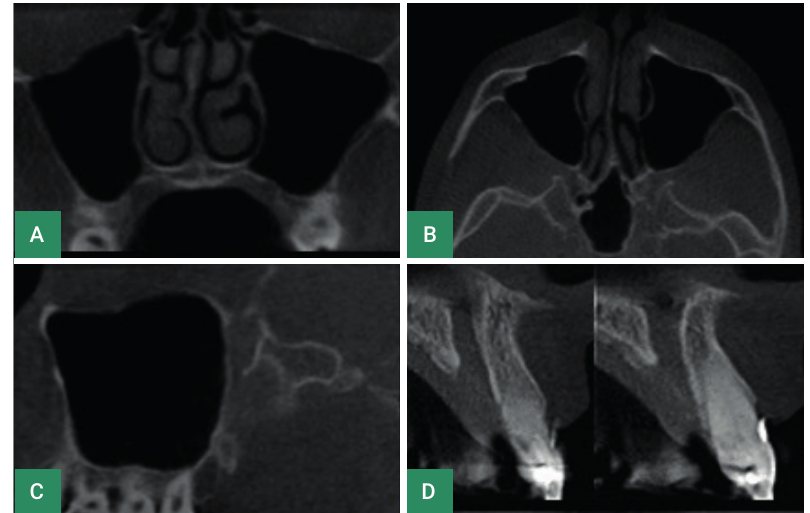
Figure 1. (A) Coronal, (B) Axial, (C) Sagital and (D) Parasagittal